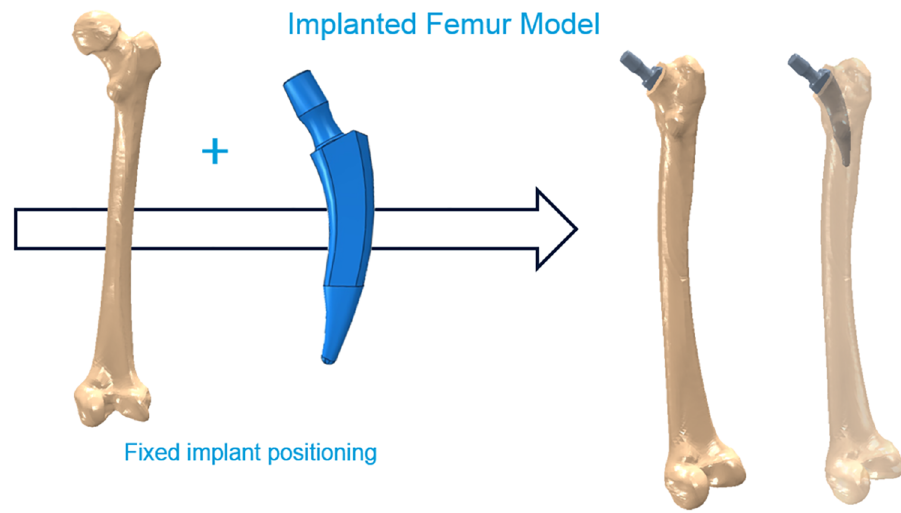
Fig 3. Implanted bone geometry. Hip implant position.